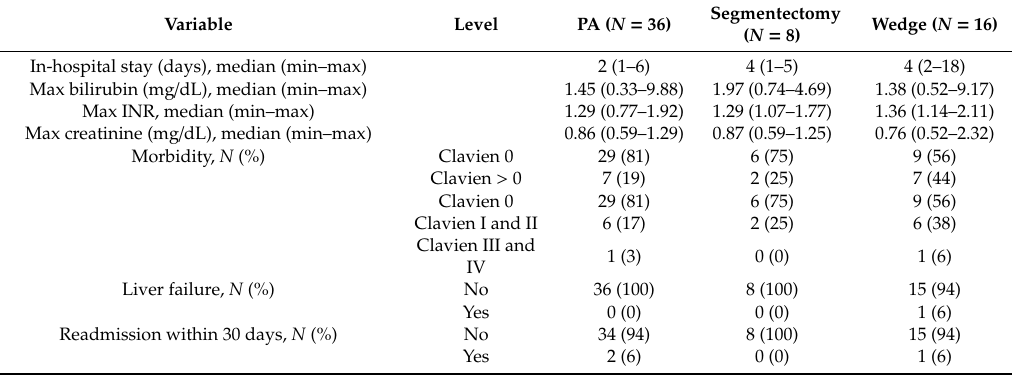
Table 4. Outcomes by RLR type of resection ( N = 60).